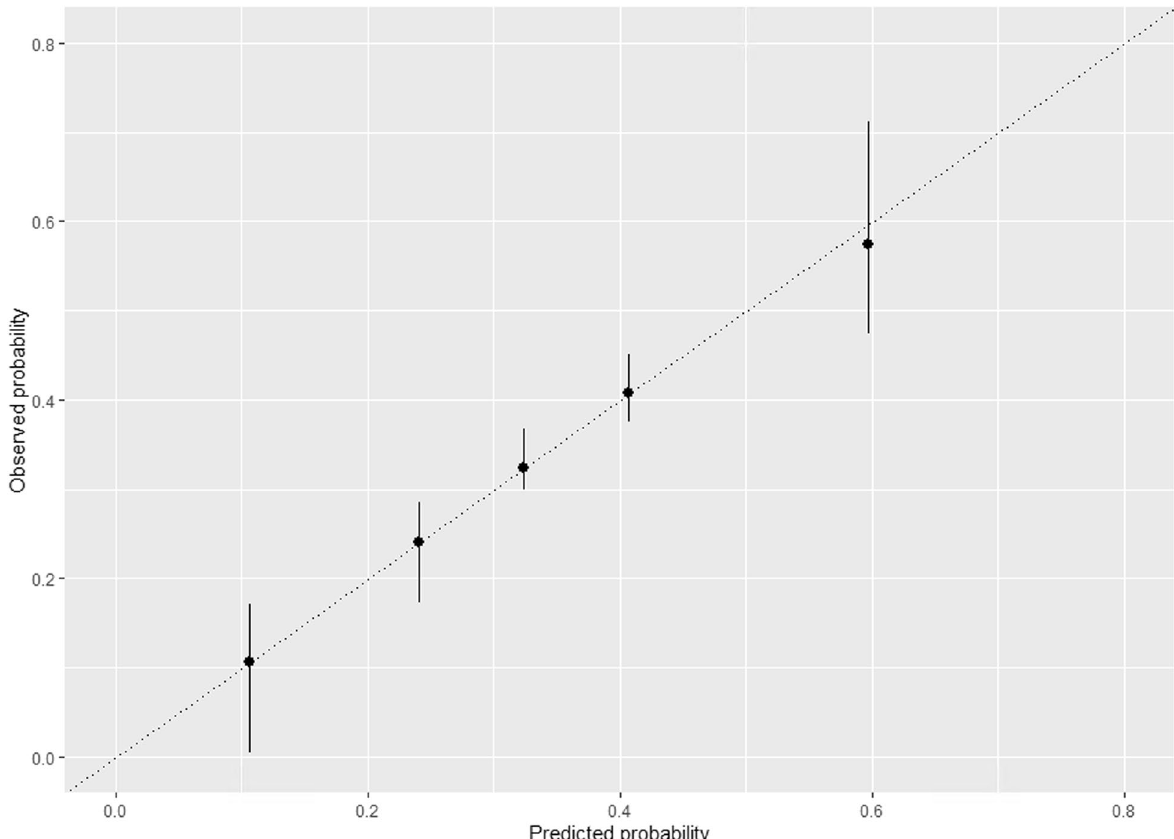
Fig. 2 Calibration of the gradient boosting machine model for psoriasis severity by quintiles of predicted